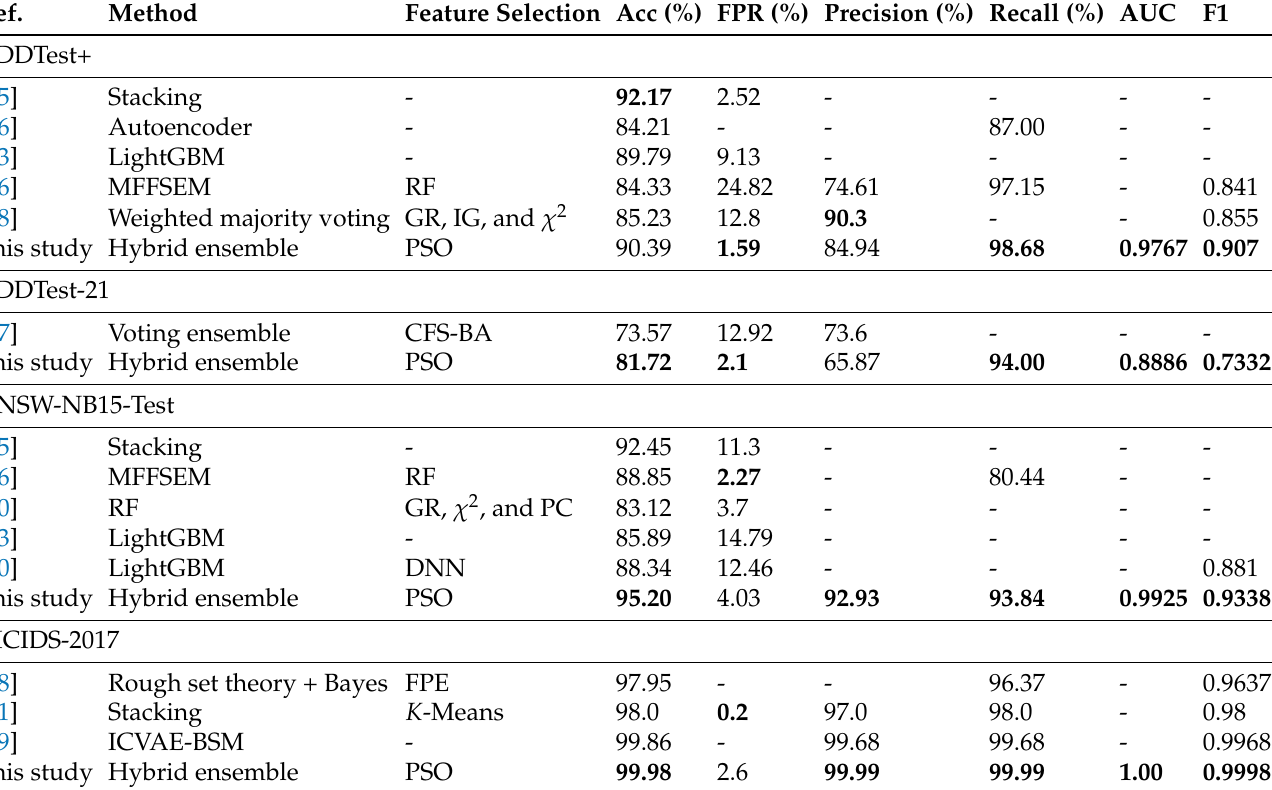
Table 4. Comparison of the proposed model’s outcomes to that of previous network anomaly detectors. Bold indicates the best